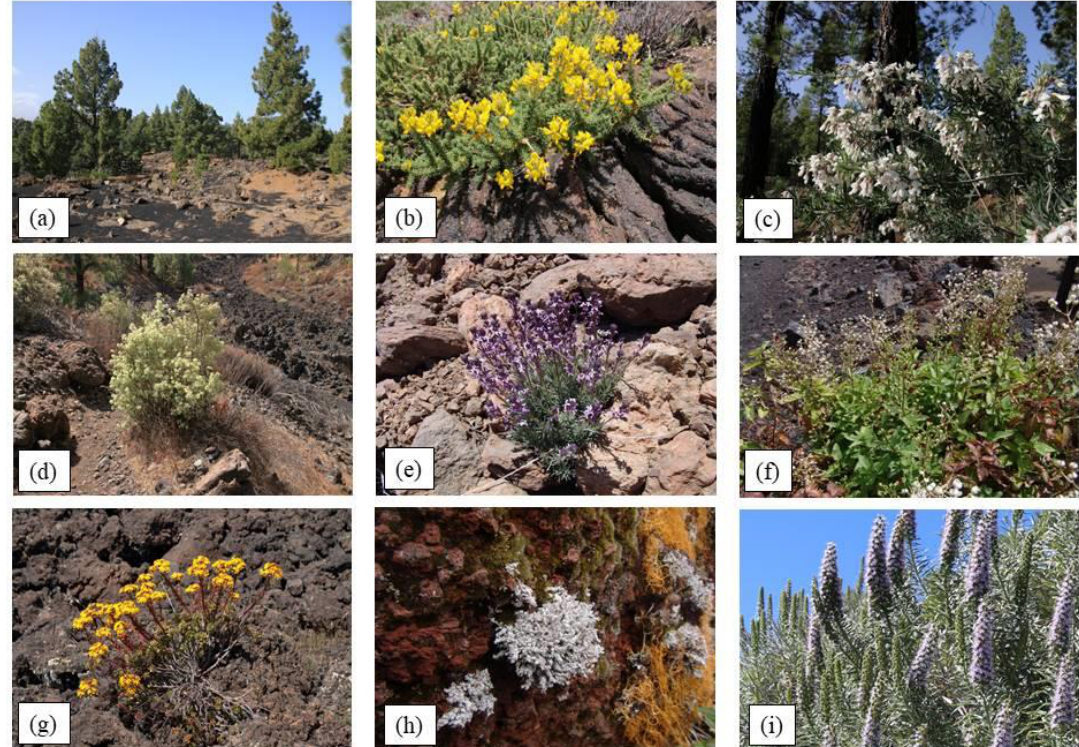
Figure 10. Common plant species on the volcanic highlands of Abeque: ( a ). Canary Island pine ( Pinus canariensis ). ( b ) . Adenocarpus viscosus subsp. viscosus . ( c ). Chamaecytisus proliferus subsp. angustifolius . ( d ). Bystropogon origanifolius . ( e ). Erysimum scoparium . ( f ). Scrophularia glabrata . ( g ). Aeonium spathulatum . ( h ). Stereocaulon vesuvianum . ( i ). Echium virescens . Source: authors.